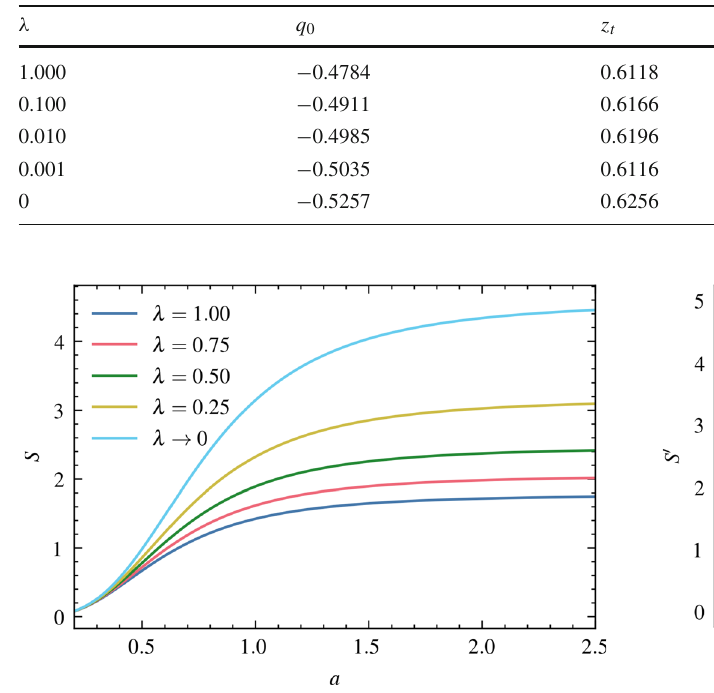
Fig. 12 Horizon entropy ( S ) as a function of scale factor ( a ) for dif- ferent values of λ (with (cid:12) m 0 = 0 . 315 and H 0 = 67 . 4 km/s/Mpc [78]). Here, λ → 0 implies (cid:2) CDM behaviour (in natural units)